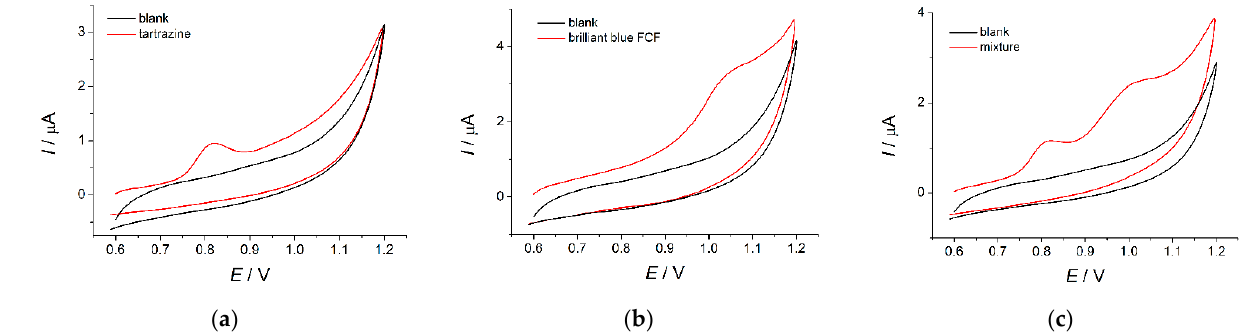
Figure 6. Cyclic voltammograms of 10 μM dyes on the MnO 2 nanorods-modified electrode in phosphate buffer pH 7.0: ( a ) tartrazine; ( b ) brilliant blue FCF; ( c ) equimolar mixture of tartrazine and brilliant blue FCF. υ = 100 mV s ‒ 1 .